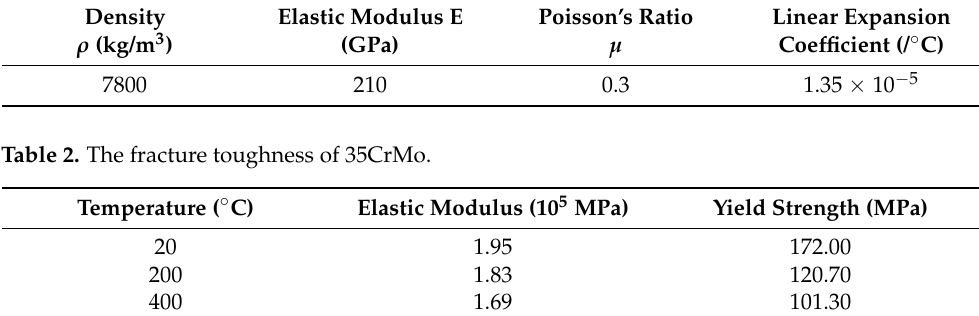
Figure 1. The geometric model of the surface of the pressure vessel bottleneck. Table 1. Pressure vessel material parameters.